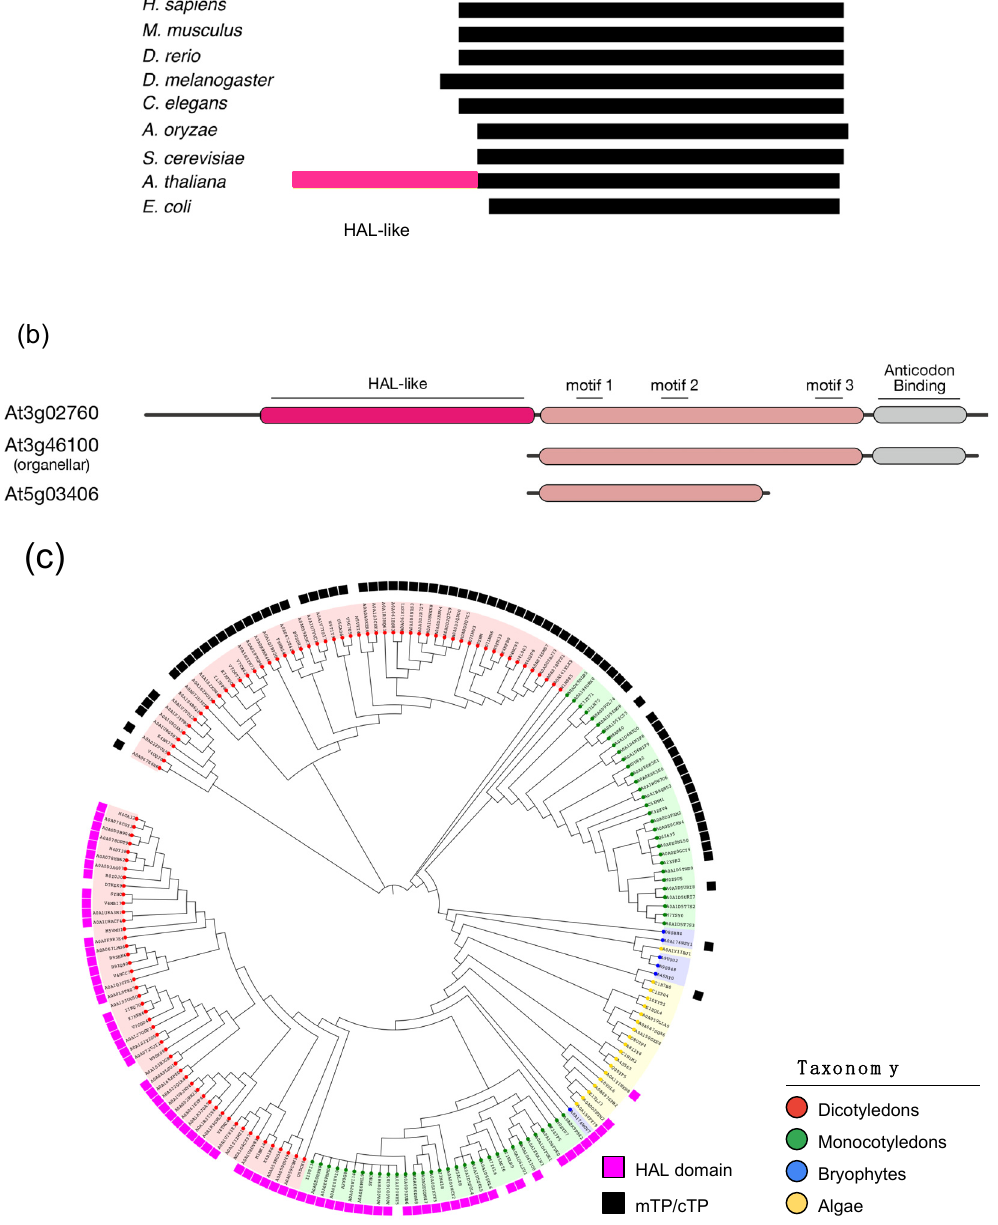
Figure 4. HisRS from plants. ( a ) Schematic representation of the full-length from various organisms. HAL-like domain (red) is only seen in plants. ( b ) Schematic representation of all three HisRS sequences in Arabidopsis. ( c ) Phylogenetic tree of HisRS from plants. Magenta-colored boxes indicate those containing a HAL-like domain in addition to the full-length catalytic domain. Black boxes indicate those containing mitochondrial (mTP) or chloroplast transit peptide (cTP) sequences, and hence are organellar forms. Sequences from different taxonomy are colored differently.